Question: Summarize what this figure shows in one sentence.
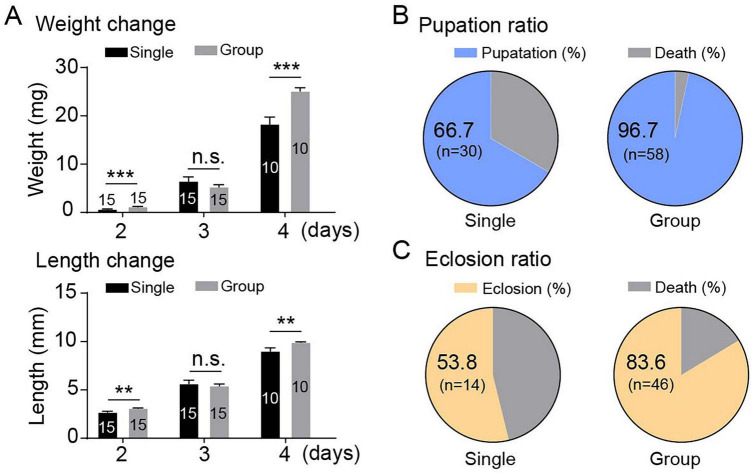
Answer: Larval growth and development of the housefly under single- and group-rearing conditions. (A) The changes in body weight (the upper) and length (the lower) of larvae when reared under single and group conditions during 4 days of rearing. (B,C) Pupation ratio (B) and eclosion ratio (C) of larvae under single- and group-rearing conditions. Measurements in (A) are shown as the mean ± SE. Statistical significance: n.s., not significant; ** P < 0.01; *** P < 0.001.